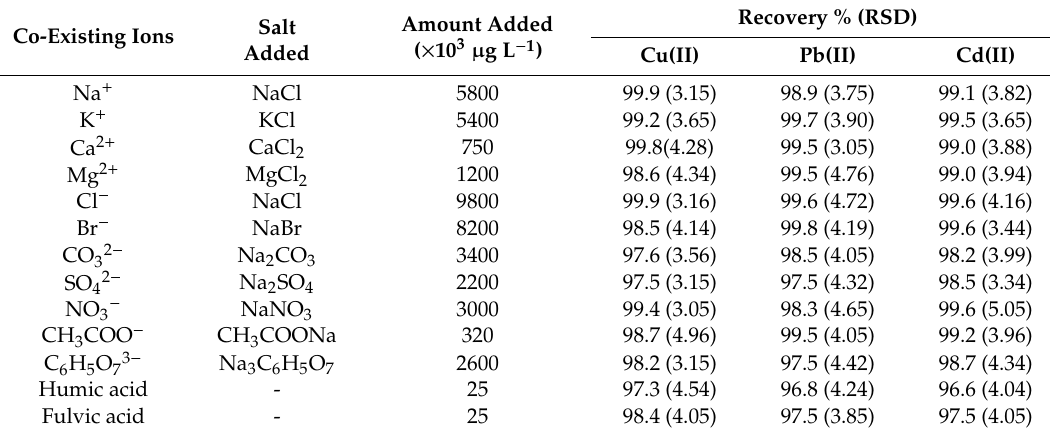
Figure 6. ( A ) Effect of sample pH on the sorption of metal ions, ( B ) effect of equilibrium time, ( C ) pseudo-second-order reaction kinetics, and ( D ) Langmuir isotherm models. Table 2. Interference studies on the adsorption of analyte ions (experimental conditions: M n + = 100 µ g L − 1